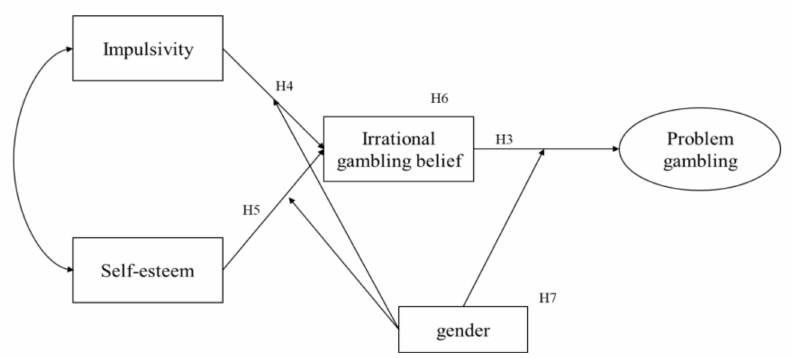
Figure 2. Alternative model.